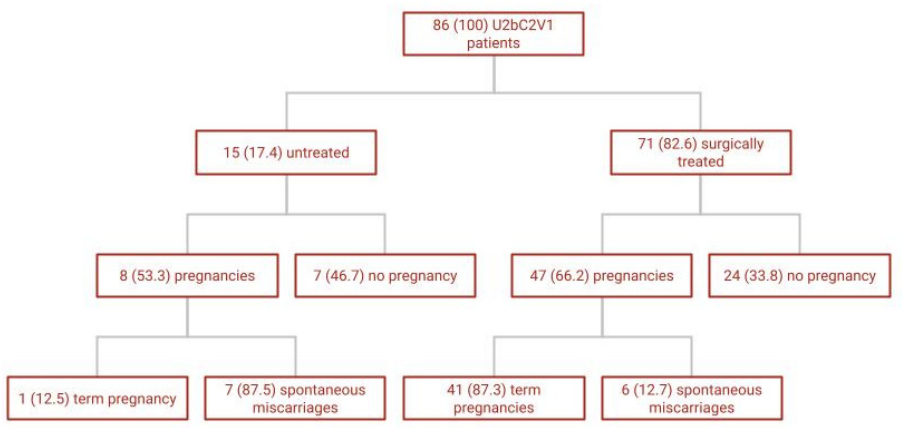
Figure 2. Fertility outcomes of overall included U2bC2V1 patients – N(%).